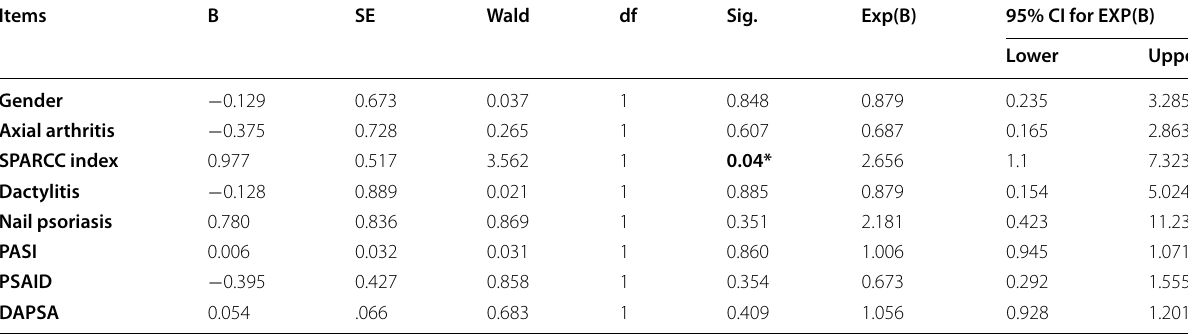
Table 7 Multivariate analysis of risk factors in patients with impaired work